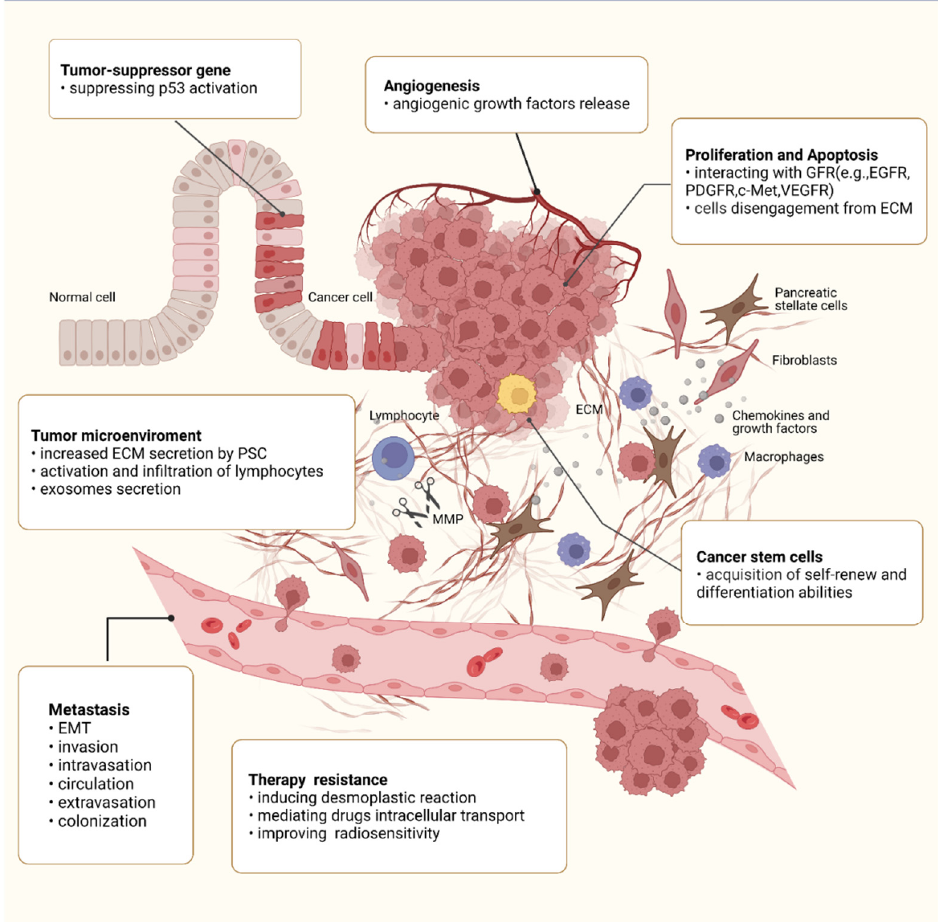
Figure 2. Roles of integrin β 1 in the malignant behaviors of PC. Integrin β 1 is involved in every step of PC progression and is responsible for regulating malignant cell behaviors such as sustained proliferation, apoptosis resistance, angiogenesis, and migration, as well as CSC property. Integrin β 1 also promotes PC metastasis, including EMT, invasion, intravasation, circulation, extravasation, and colonization. In the tumor microenvironment, integrin β 1 has been implicated in extensive desmoplastic reaction and regulates the expression of MMPs, the release of GF, and the activation and infiltration of lymphocytes. In addition, integrin β 1 also plays an important role in the acquisition of treatment